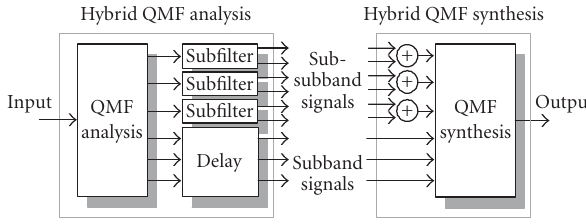
Figure 7: Structure of the hybrid QMF analysis and synthesis filter banks.